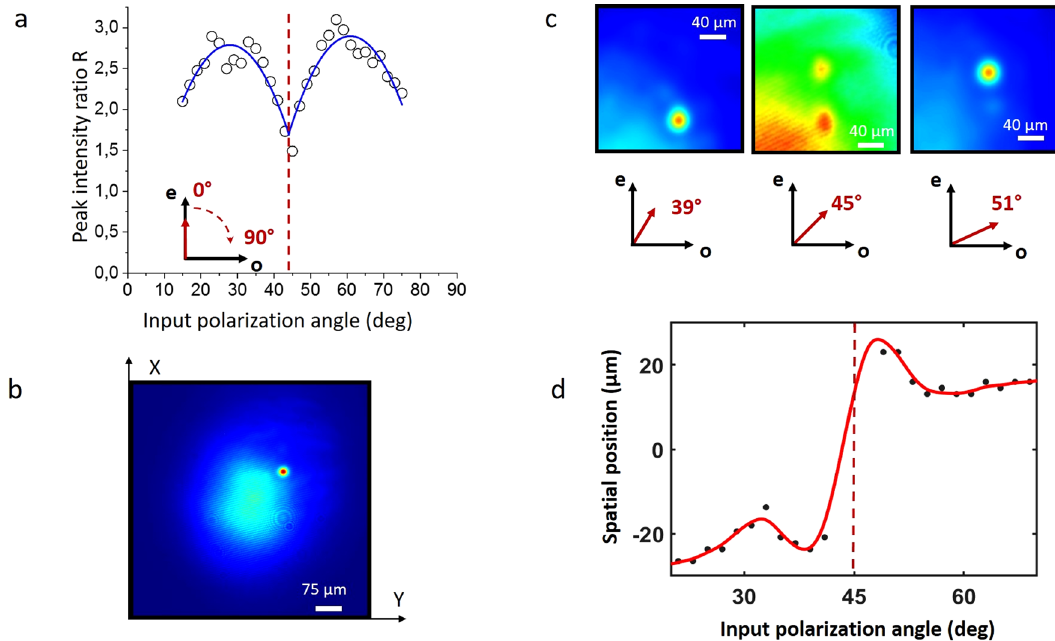
Fig. 4 Experimental results on the ef fi ciency of the 2D spatial twin spotlight beam (TSB) trapping and associated spatial switching. a Peak intensity ratio between the TSB and the input beam; b Example of TSB generation for an input polarization orientation angle α = 60°; c Example of TSB spatial switching for three different input polarization angles; d Spatial position of the TSB vs. the input polarization angle α (input beam intensity I FF =